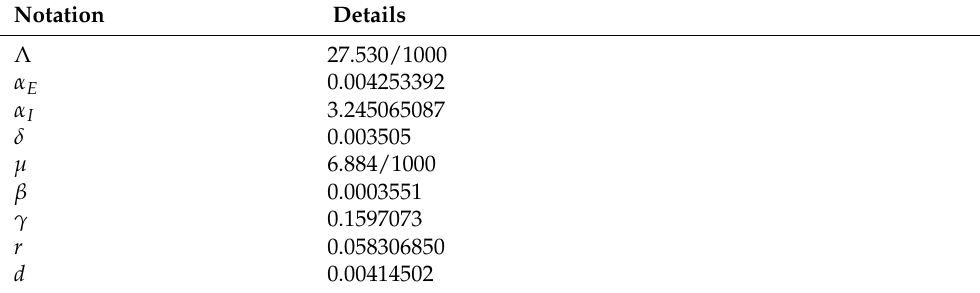
Table 1. Description of the parameter of (1).